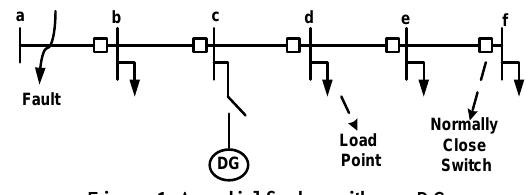
Figure 1. A radial feeder with one DG